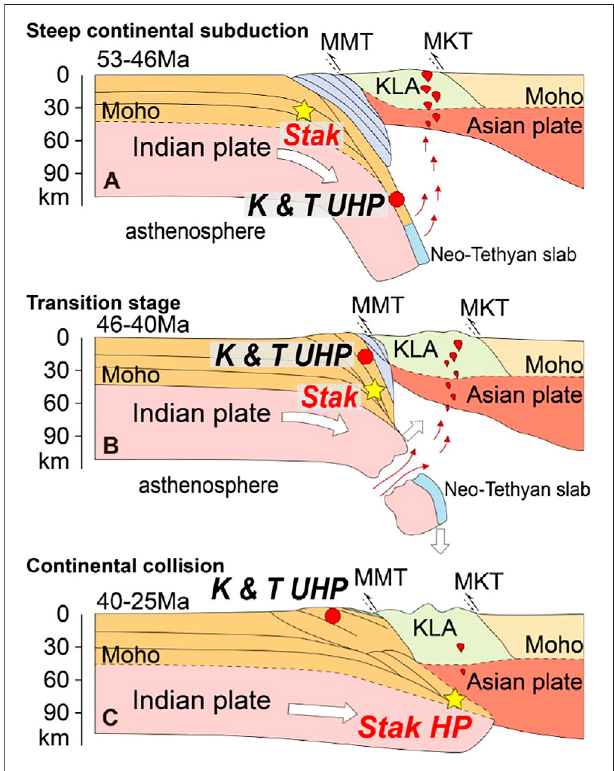
FIGURE 8 | Integrated peak P - T conditions and ages of eclogites and HP granulites in the Himalayan orogen. The age data sources are listed in Supplementary TableS6 . Sourcereferencesfor P - T conditions: Annapurna (Ap) (Kohn and Corrie, 2011), Ama Drime (AD) (Li et al., 2018), Arun (Ar) (Corrie et al., 2010), Ayilari (Ay) (Chen et al., 2021), Bhutan (Bh) (Grujic et al., 2011),Dinggye (Dg) (Wang et al., 2017), Kaghan (Kaneko et al., 2003), Sikkim (Sk) (Faak et al., 2012), Stak (Lanari et al., 2013), Tso Morari (Mukherjee et al., 2005), Yadong (Ya) (Zhang et al., 2017), Namche Barwa Syntaxis (NBS) (Zhang et al., 2015), and Zanskar (Zk) (Vance and Harris, 1999).